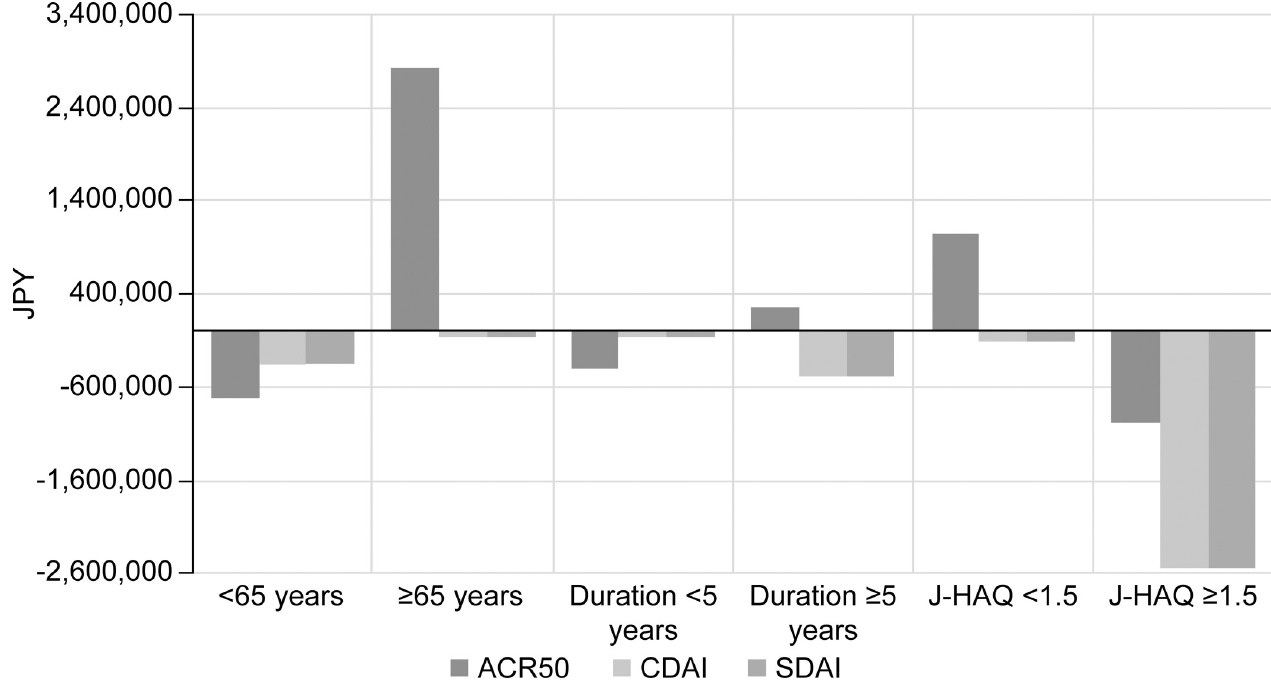
Fig 4. Scenario analyses: Differences in cost per patient achieving endpoints (ABA-1L vs. ABA-2L+). Difference in costs per health gain PMPM (ABA-1L – ABA-2L+). Costs per health gain PMPM were calculated by dividing total costs by the number of responders, patients in CDAI or SDAI remission for each group. The more positive the vertical axis, the more cost-effective the ABA-2L+ was. 1L, first line; 2L+, second or later line; ABA, abatacept; ACR50, American College of Rheumatology response of at least 50% improvement; CDAI, Clinical Disease Activity Index; J-HAQ, Japanese version of Health Assessment Questionnaire; JPY, Japanese Yen; PMPM, per member per month; SDAI, Simplified Disease Activity Index.